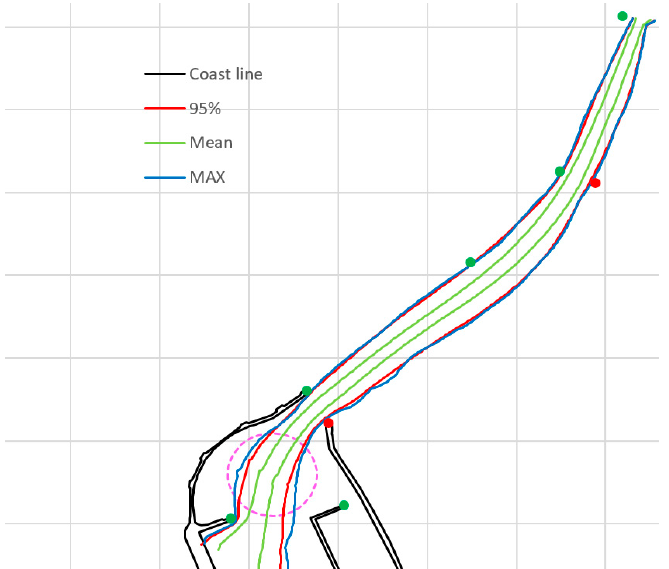
Figure 13. Manoeuvring areas of L = 133 m general cargo ship on approach to modernized Ustka Port using the standard method with final navigational marking.